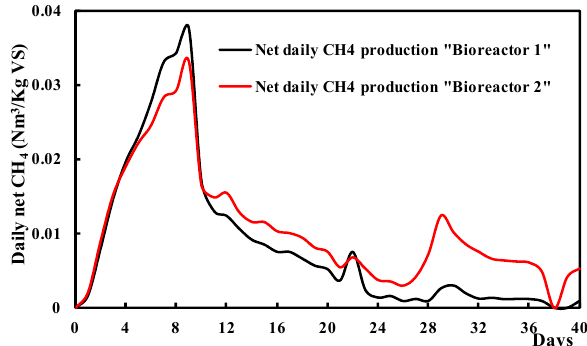
Figure 7. Net cumulative bio-methane production of the two bottles.